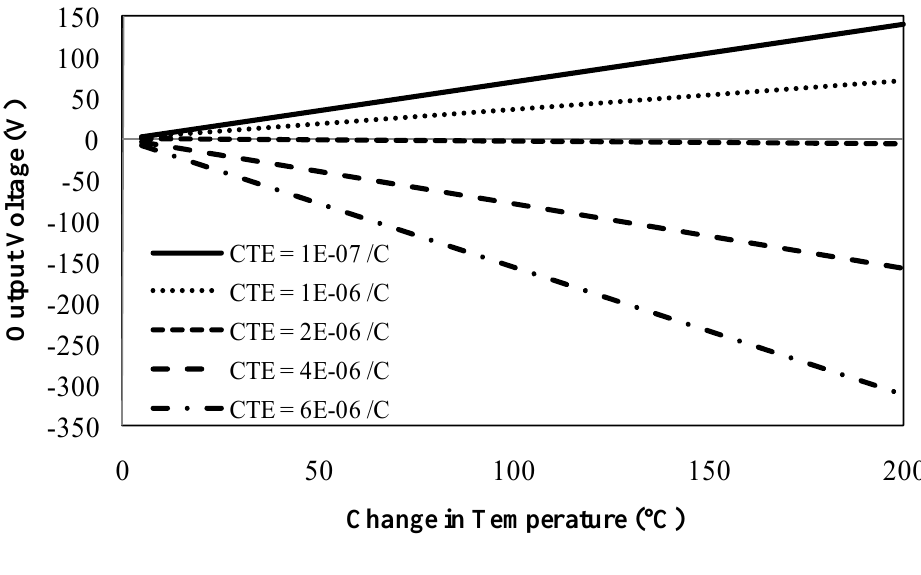
Figure 15. Induced voltage response relative to the change in temperature for a range of